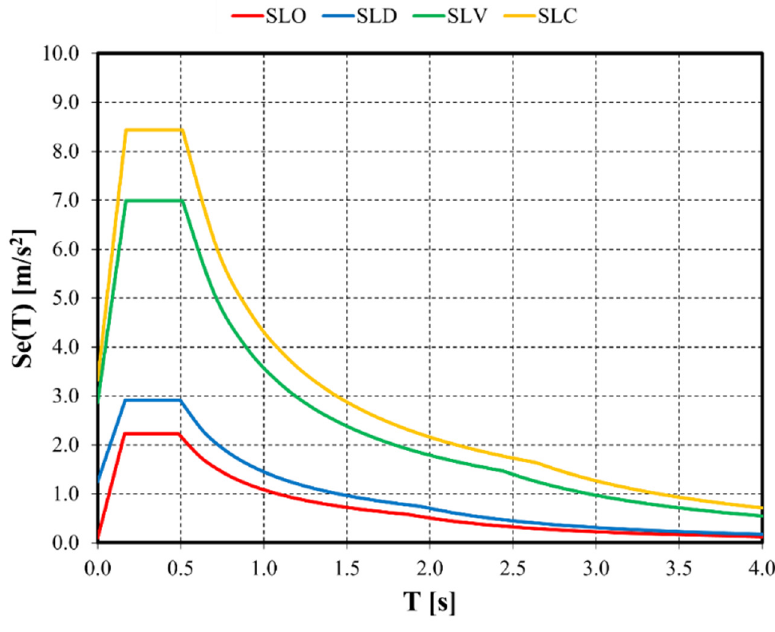
Figure 6. Elastic response spectra.